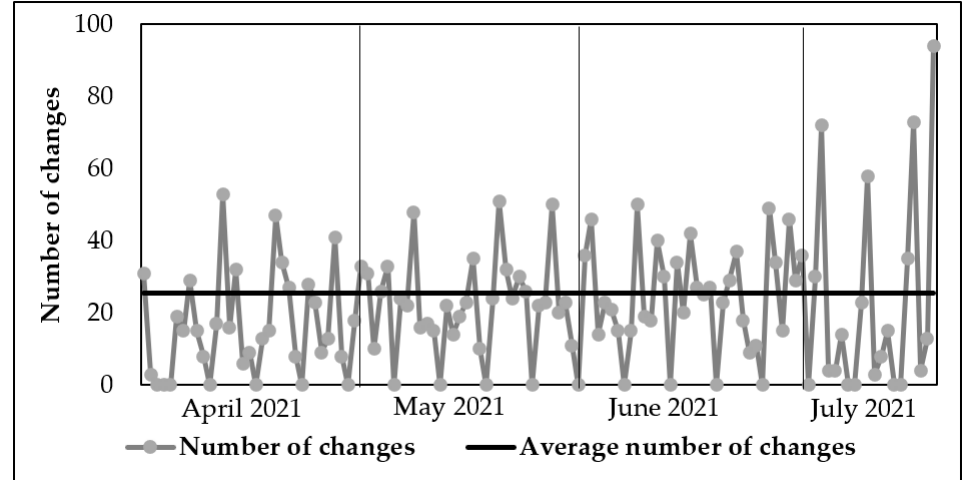
Figure 5. Number of changes in Variant 1 .